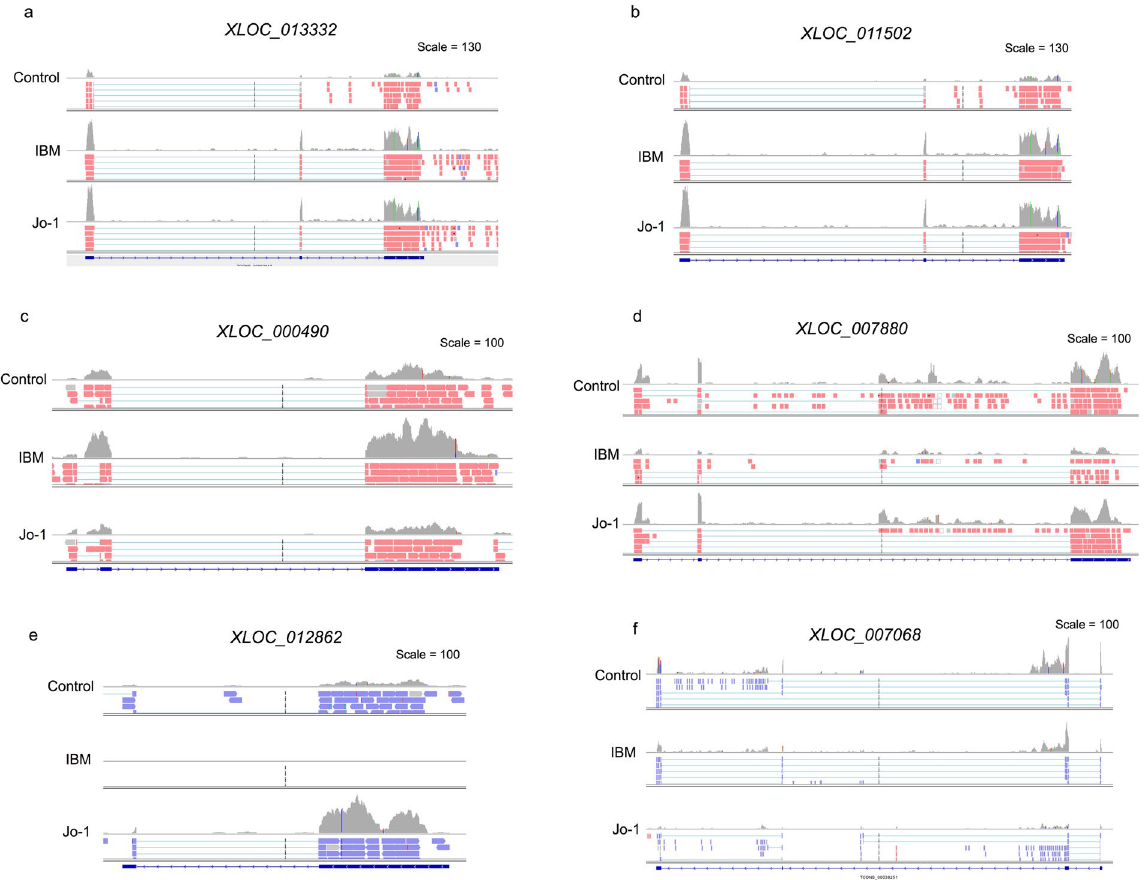
Figure 5. Differential expression of novel lncRNAs in control, IBM and Jo-1 myositis. View from the Integrated Genome Viewer (IGV) of aligned sequence data for novel lncRNA that are up-regulated ( a , c , e ) and down- regulated ( b , d , f ) in both IBM and Jo-1 myositis ( a , b ), IBM alone ( c , d ) and Jo-1 alone ( e , f